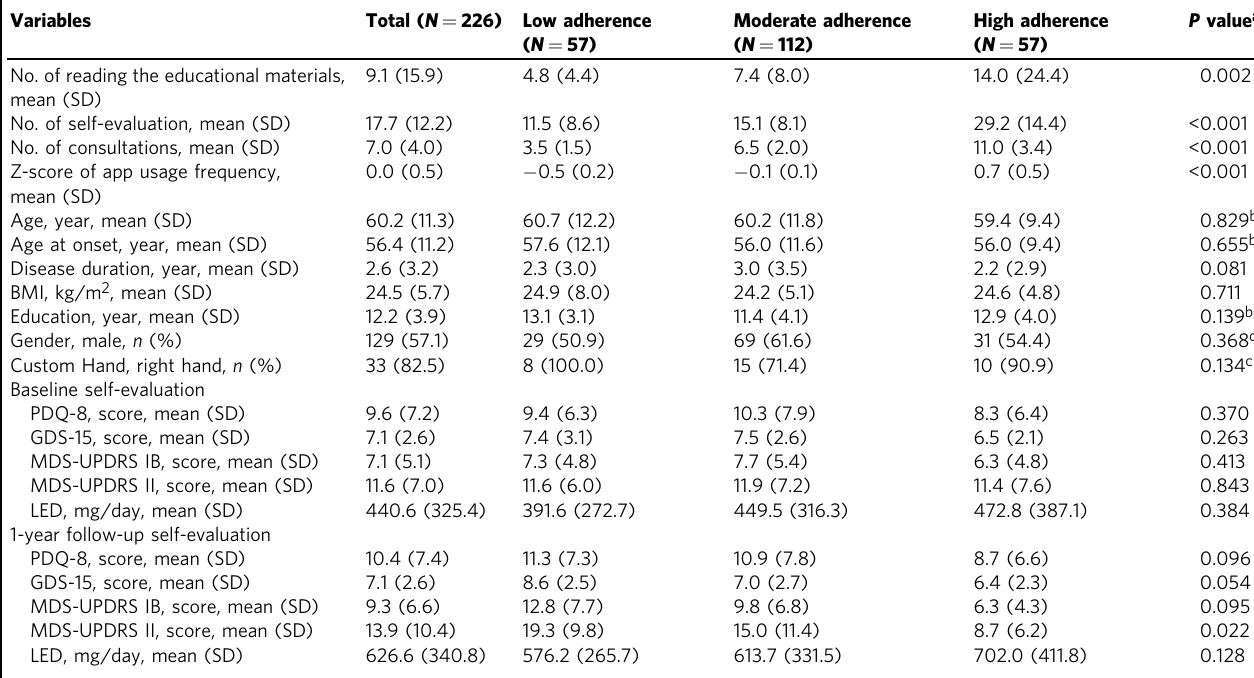
Table 1 Baseline and 1-year follow-up clinical features of participants.